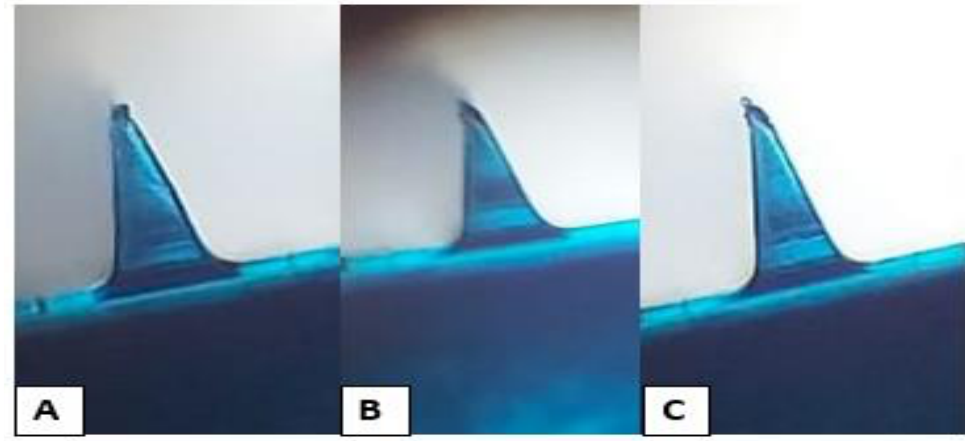
Figure 10. Polarizer photographs representing a decrease in the height of MN-3 after applying different forces of ( A ) 200 g, ( B ) 500 g, and ( C ) 1000 g.